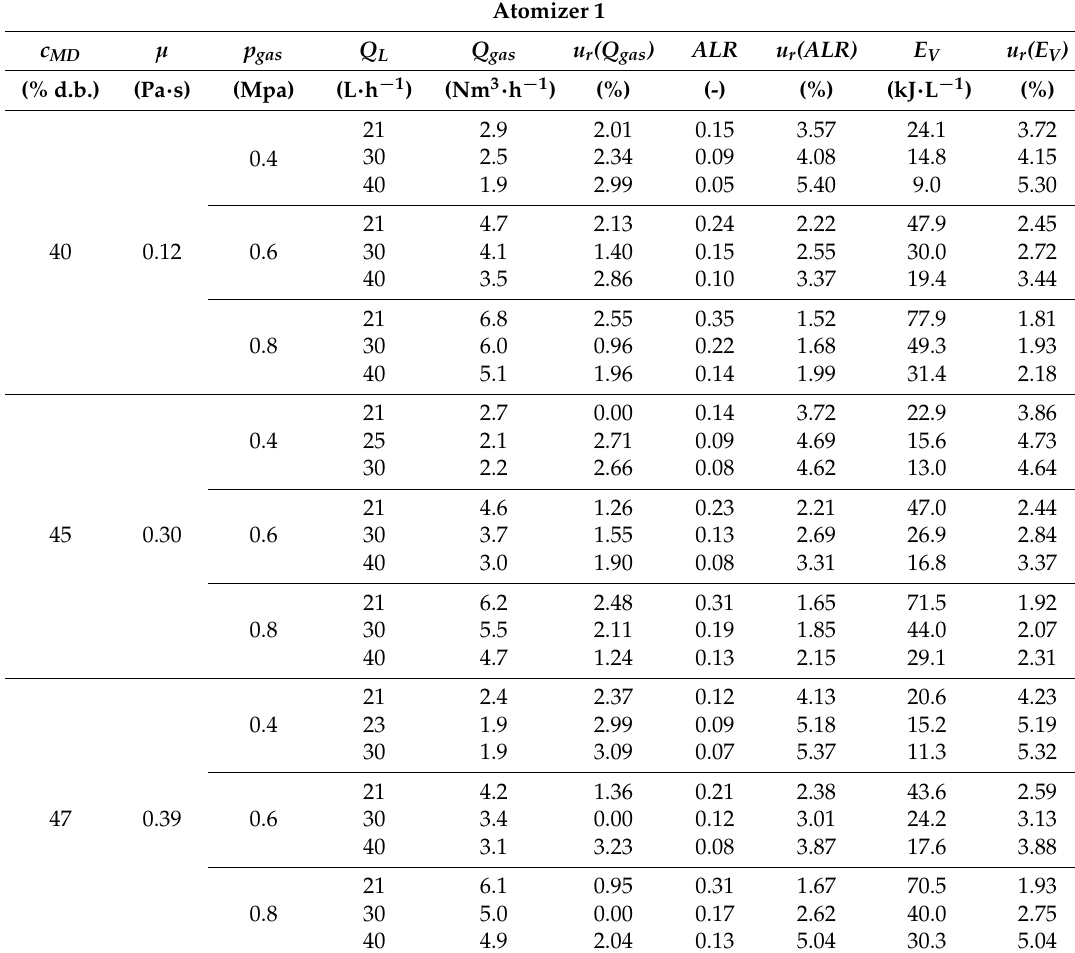
Table 3. Gas pressures ( p gas ), liquid volume flow rates ( Q L ), resulting gas volume flow rates ( Q gas ), air/liquid mass ratios (ALR) and volumetric energy densities ( E V ) for atomizer 1 together with the uncertainty values u r ( γ ) of measured/calculated parameters Q ga s , ALR, and E V . Measurement values of Q gas are reported at normal conditions (273.15 K, 0.1013 MPa abs ) in normal cubic meters per hour (Nm 3 · h − 1